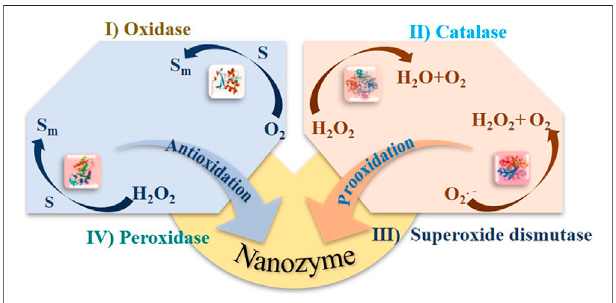
FIGURE 5 | Functions and catalytic mechanisms of nanozymes (S,